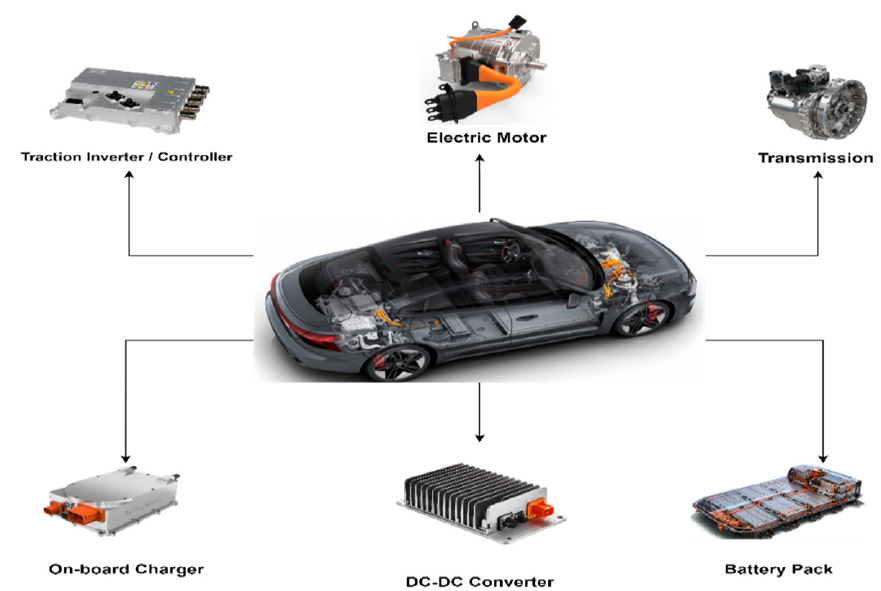
Figure 3. Main components of an EV propulsion drive system.